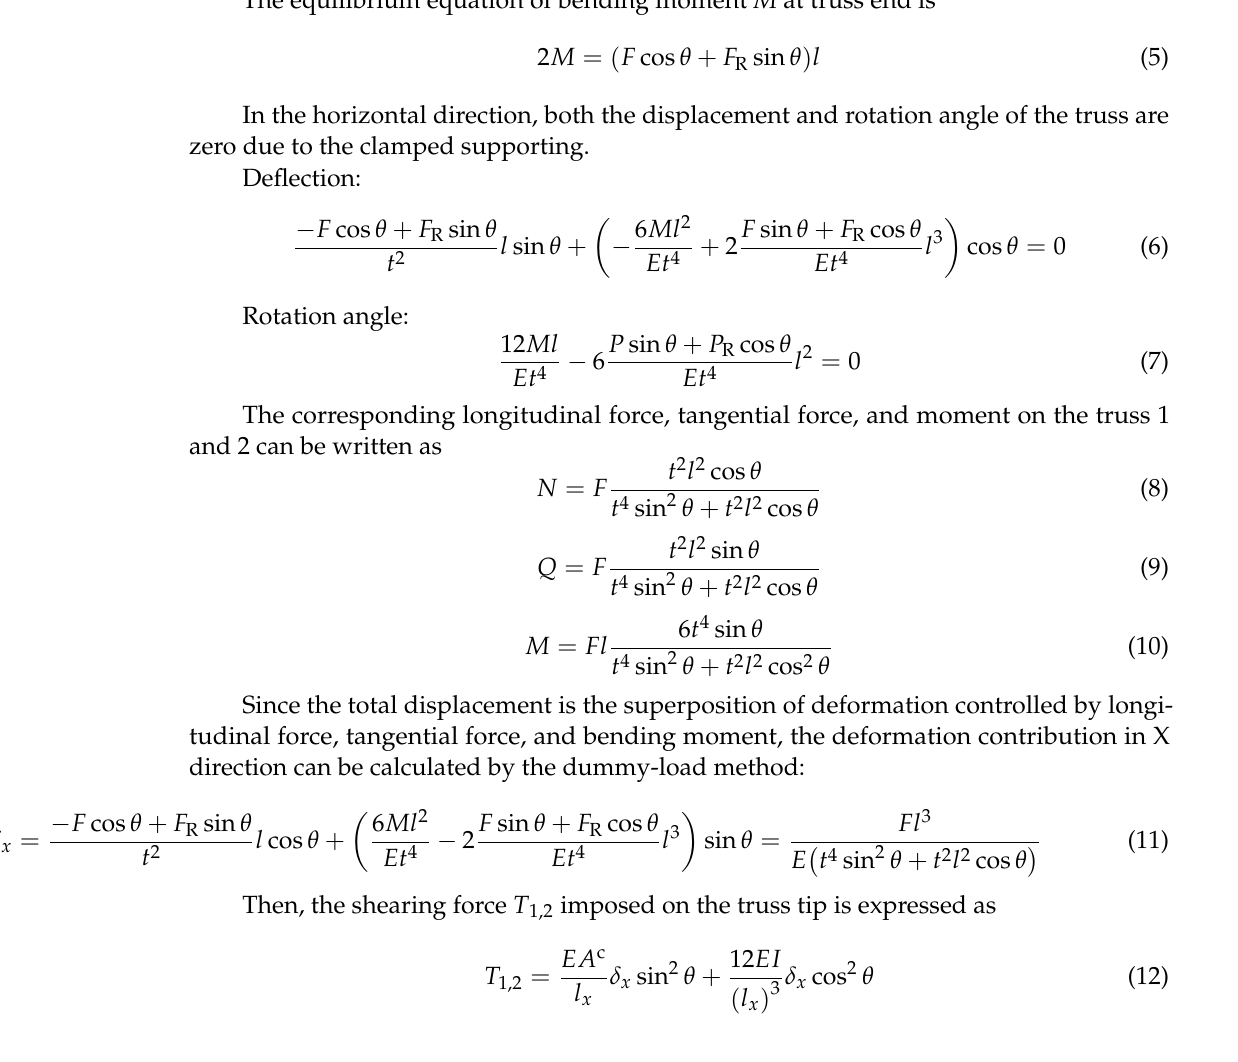
Figure 7. Sketch of loading distribution on individual truss under shearing ( a ) and compression ( b ). The equilibrium equation of bending moment M at truss end is